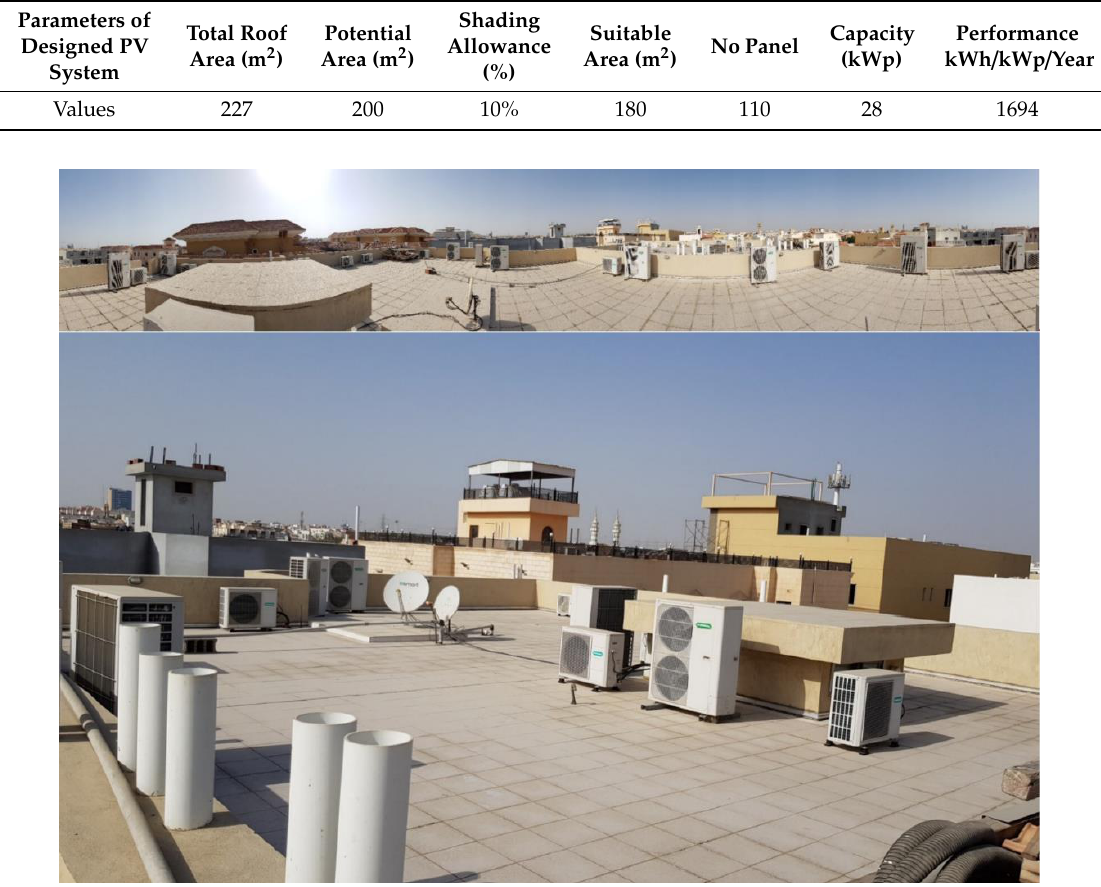
Figure 23. ( a ) Monthly generated power from solar PV panels and ( b ) monthly solar irradiation vs Temperature.